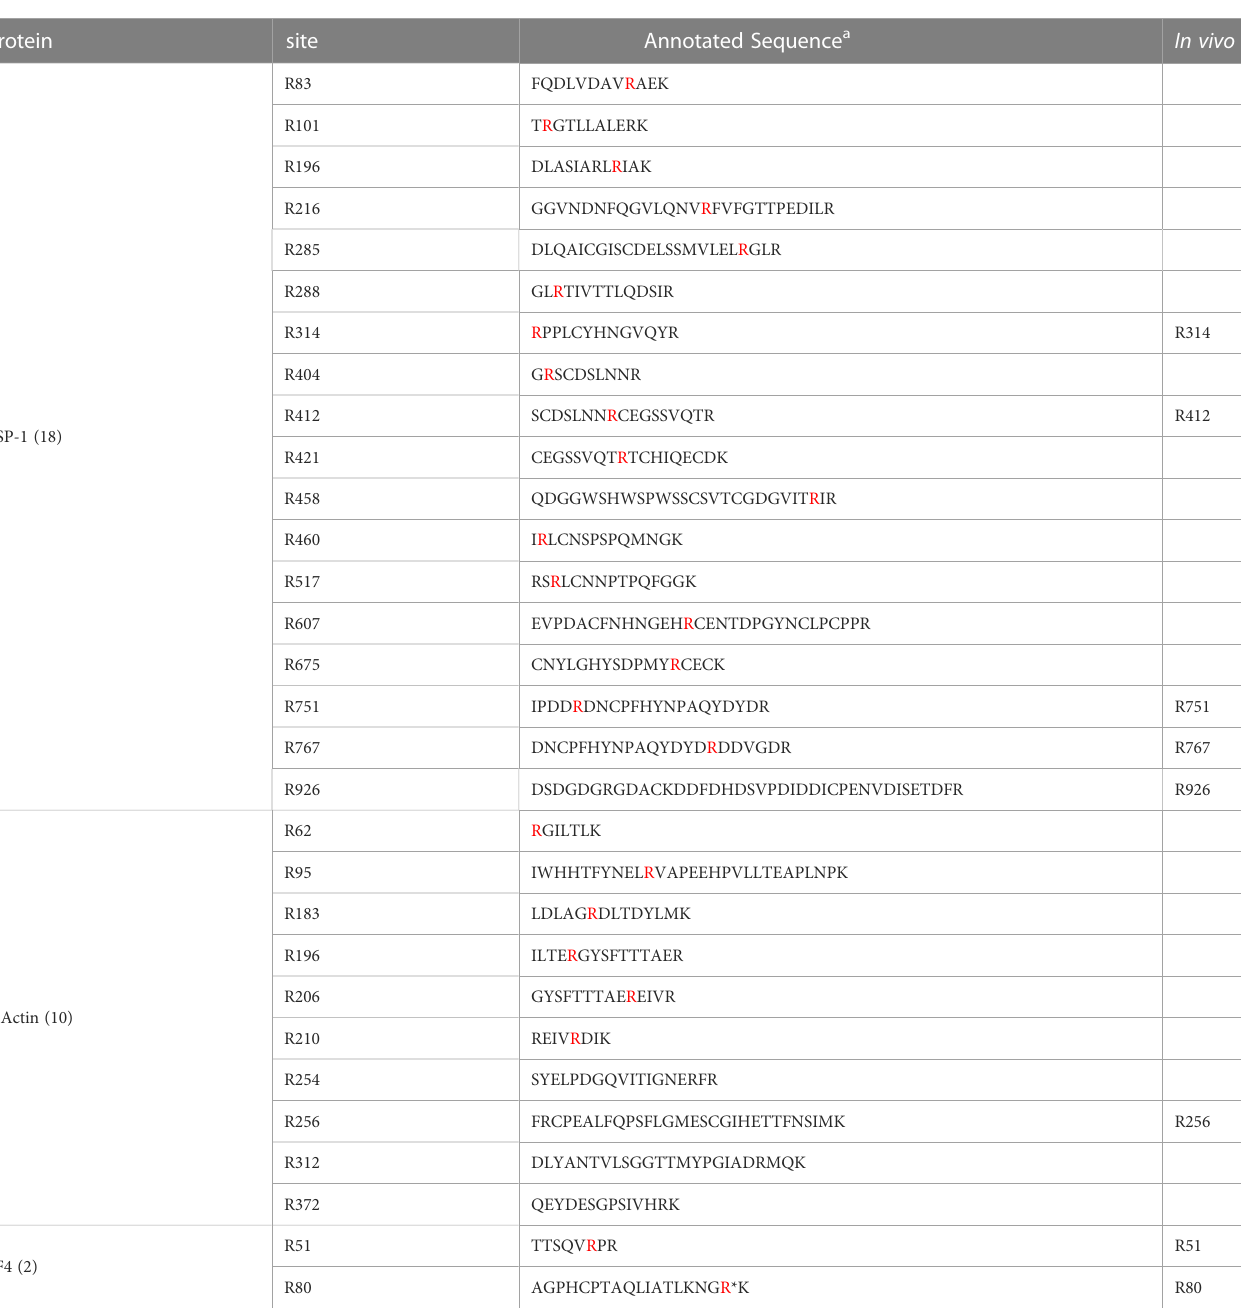
TABLE 3 Citrullination sites present in TSP-1, b -actin, and PF4 by PAD4 catalysis. protein site Annotated Sequence a In